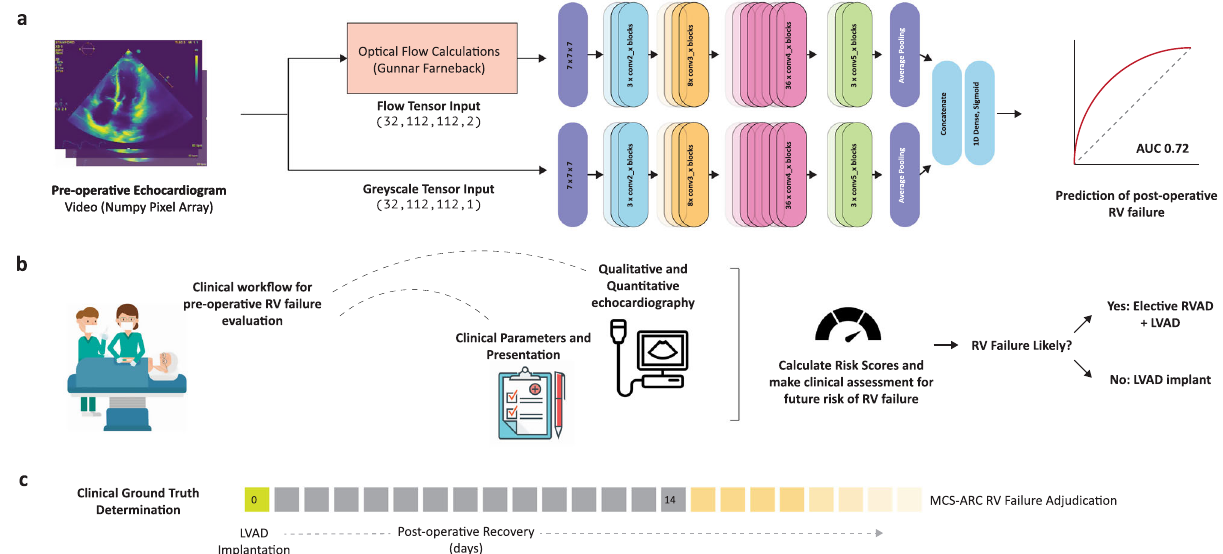
Fig. 1 Overview of the project. a Pre-operative echocardiography videos are processed as a stack of 32 frames. A two-stream implementation of raw greyscale videos and optical fl ow channels are fed into a 3D convolutional neural network to produce the prediction of RV failure. b The clinical work fl ow for predicting future risk of RV failure begins in the pre-operative phase using a combination of clinical parameters and a detailed echocardiographic assessment. Risk scores such as the CRITT and Penn scores are calculated thereafter to aid in risk strati fi cation following which a decision is made to either electively implant a concomitant RVAD or proceed with LVAD alone. c The clinical ground truth is determined largely by the persistent need for inotropes past post-operative day 14 or right ventricular mechanical circulatory assist devices during the post-operative recovery period. MCS-ARC de fi nitions are detailed in Supplementary Table 1. Artwork attribution from left to right in ( b ): Wikimedia Commons by Videoplasty.com; Anton Kalashny; Ralf